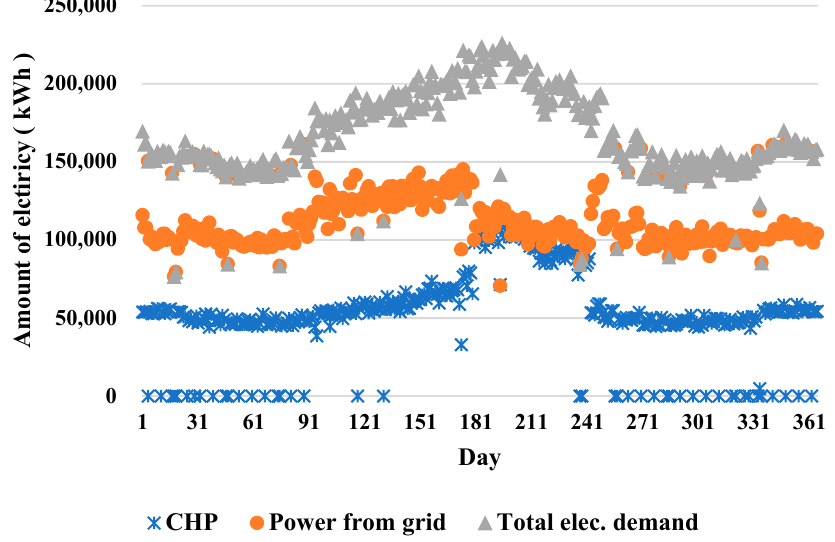
Figure 2. Annual daily power demand and supply profile for Case A.